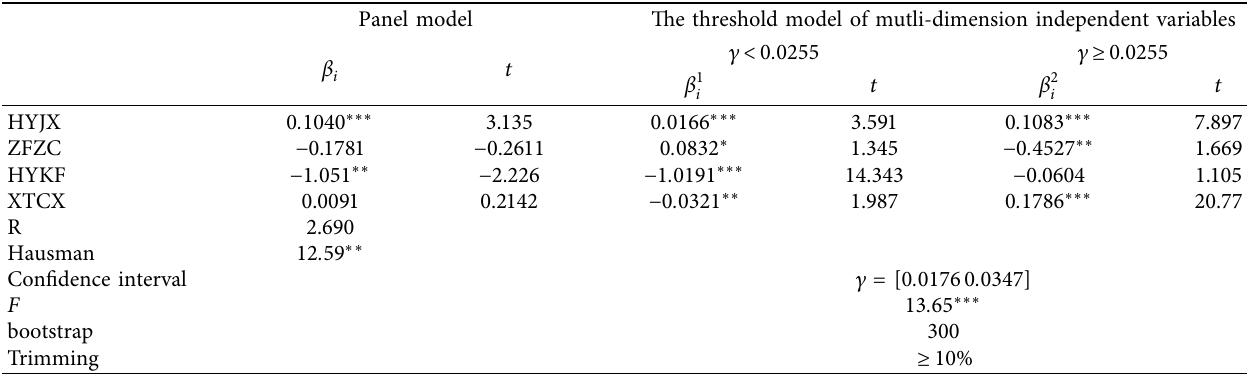
Table 5: Te results of model